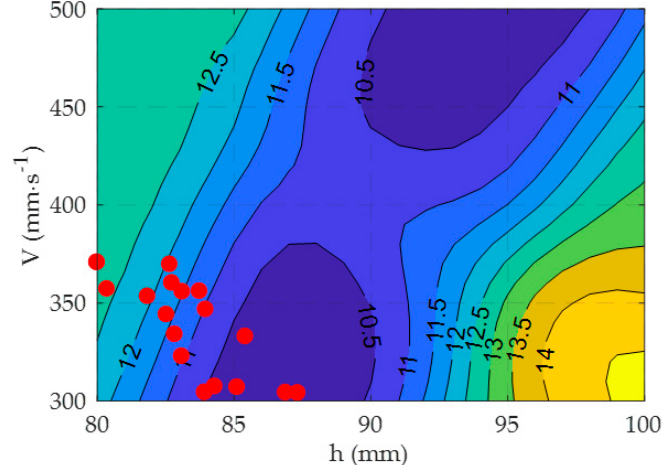
Figure 12. Contour plot of the function MDE (h, V) with optimal solutions (red dots).